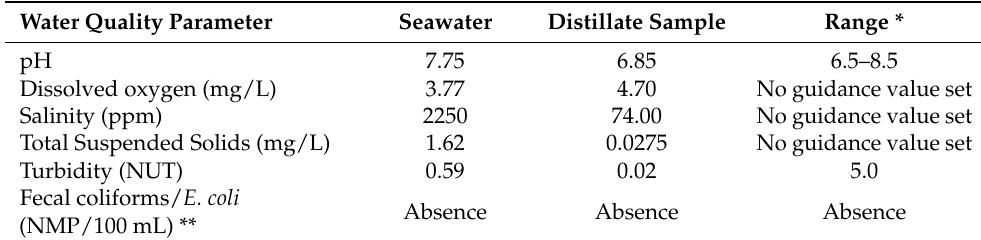
Table 4. Physicochemical parameters of the sea and distilled